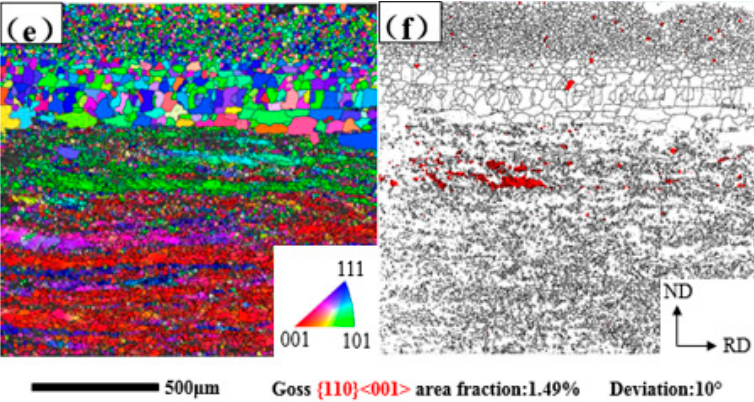
Figure 6. IPF maps of normalizing annealed specimens and the Goss texture distribution. Figure 7 is the orientation distribution function (ODF) map, which shows the main components of the texture in three samples. In the 920 °C normalized specimen, the texture is {001}<110>, {112}<111>. In the 950 °C normalized specimen, the texture is {111}<110>, {110}<001>. In the 980 °C normalized specimen, the texture is {001}<110>, {111}<110>.